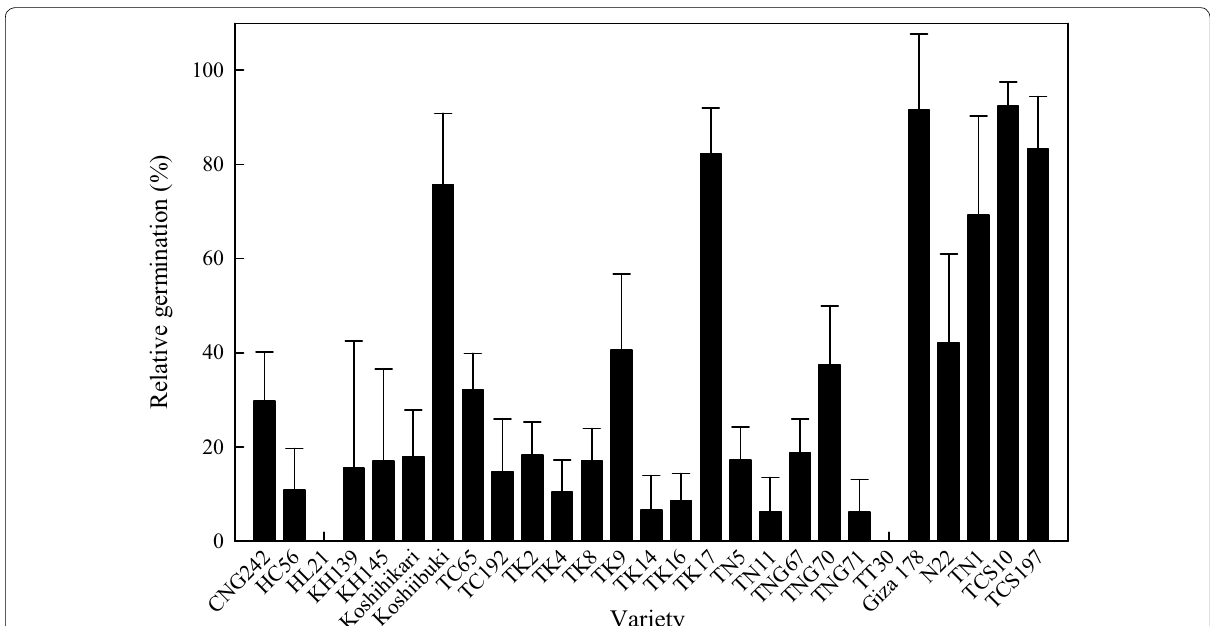
Fig. 3 Relative germination rates of different varieties after 2 weeks of 42 °C treatment. Different letters above the bars indicate a significant difference at the 0.05 level